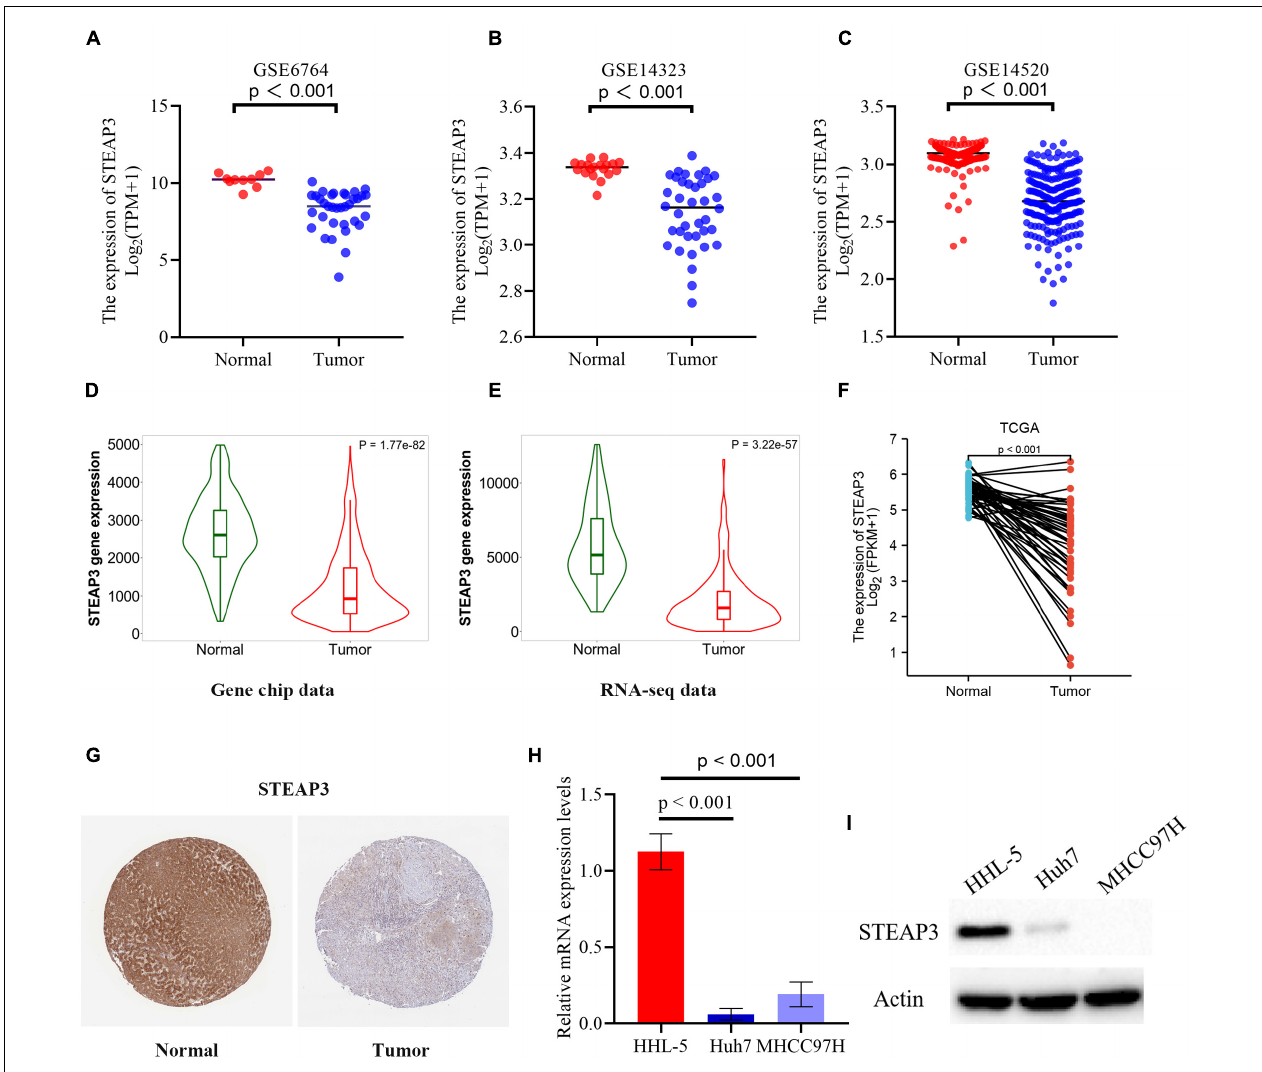
FIGURE 3 | The expression level of STAEP3 in LIHC tissues and cells. (A–C) In comparison with normal liver tissues, STEAP3 expression was significantly diminished in LIHC tissues in three GEO datasets. (D,E) The expression level of STEAP3 was lower in LIHC compared with normal tissues from gene chip data and RNA-seq data of TNMplot database. (F) STEAP3 expression was dramatically restricted in LIHC compared to non-cancerous adjacent tissues from TCGA database. (G) Representative immunohistochemical image of STEAP3 in tumor tissues showed prominently diminished protein expression relative to normal tissues from HPA database. (H,I) STEAP3 levels were determined using PCR and western blot, respectively. β -actin was used for the loading